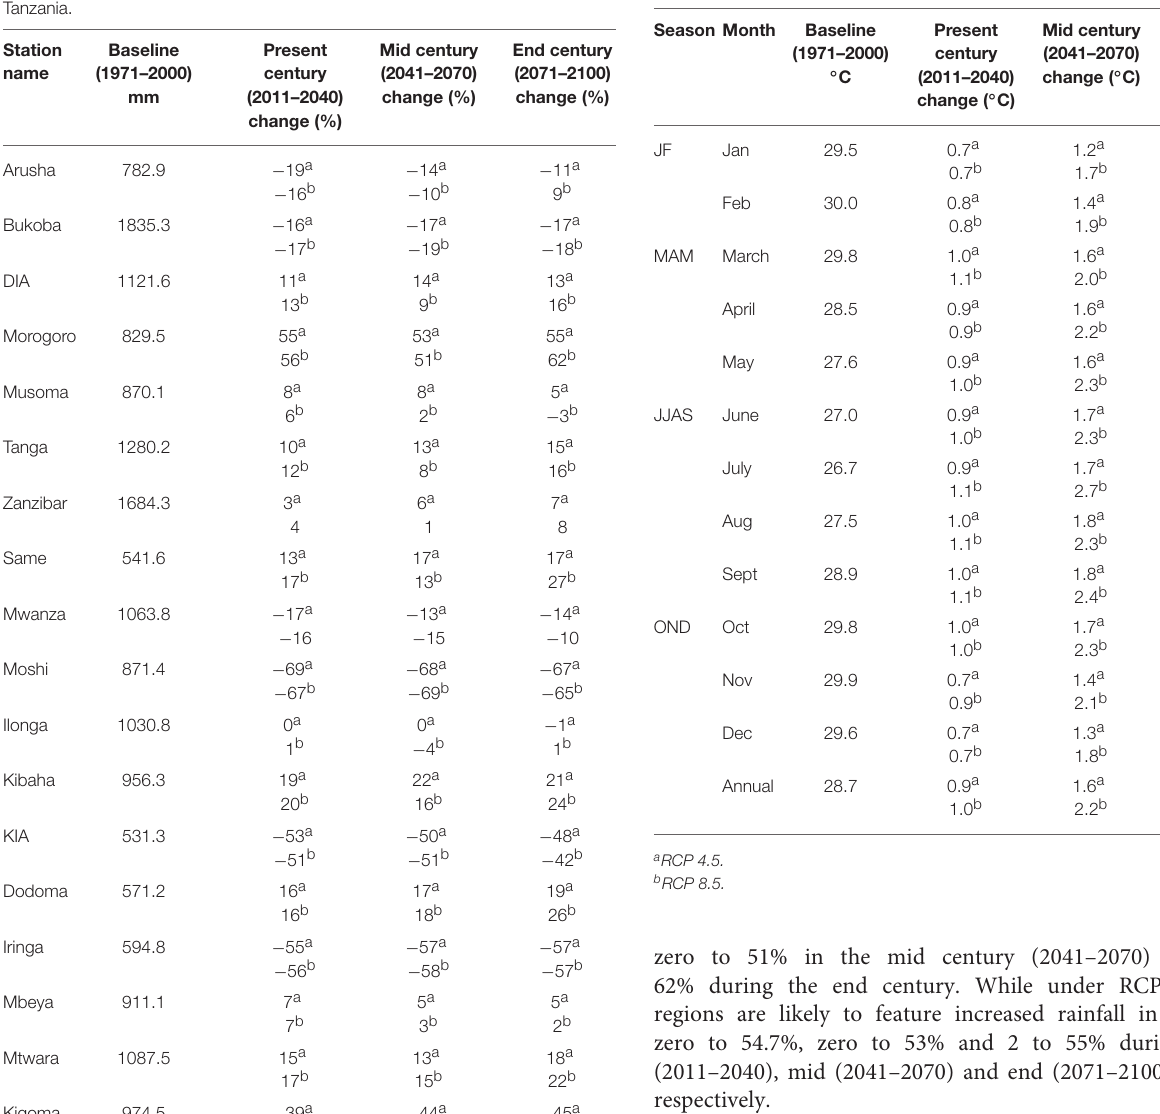
TABLE 6 | Projected changes in maximum temperature for